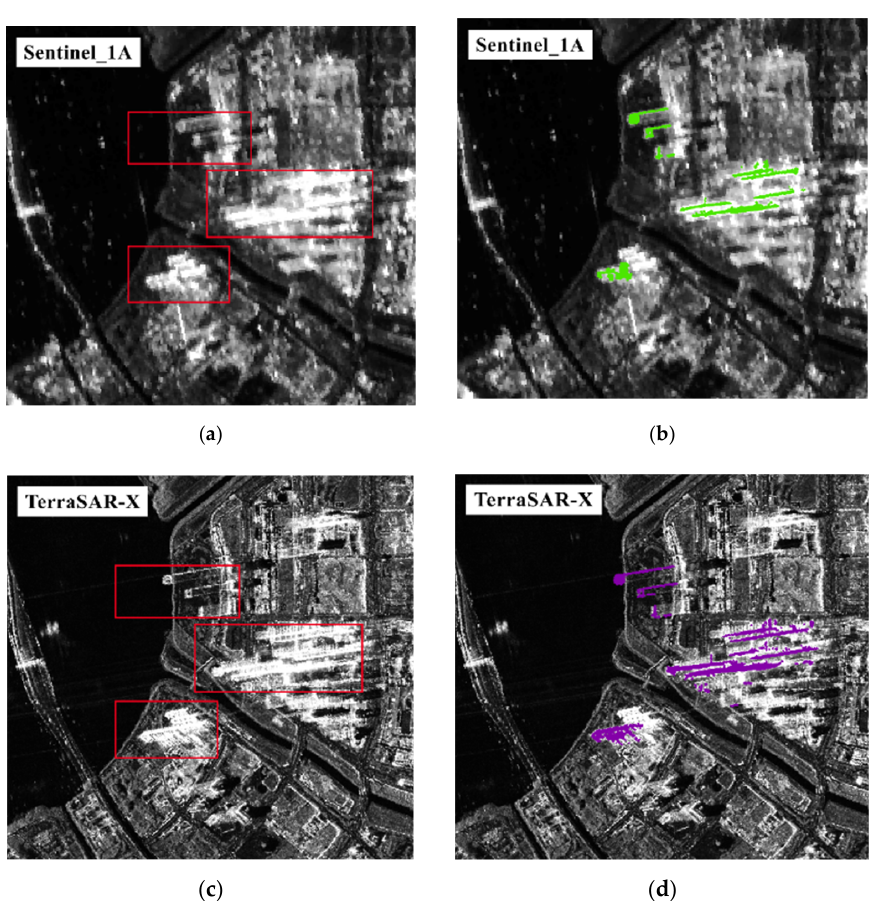
Figure 6. ( a ) Sentinel-1A image of the Qianhai Bay; ( b ) layover areas in the Sentinel-1A image; ( c ) TerraSAR-X image of the Qianhai Bay; ( d ) layover areas in the TerraSAR-X image. PS points corresponding to buildings are geometrically often seriously distorted, and there is a certain deviation when superimposed on an urban laser point cloud model, as shown in Figure 7a. The red and green dots represent the PS points of the Sentinel-1A and TerraSAR-X data, which display a distinct geometric deviation to buildings. The lower the resolution of the SAR images is, the more serious the deviation. To obtain an improved match between the SAR PS points and the urban laser point cloud model, the SAR points need to be refined. The DSM covering Shenzhen with a grid of2 m × 2 m derived by airborne LiDAR recordings was taken as control information to realize the high-precision geometric cor- rection. Figure 7b shows the InSAR match before and after geometric correction based on TerraSAR-X images, while Figure 7c,d illustrates the InSAR match before and after geo- metric correction based on Sentinel-1A images. The deviation of originally 4–5 pixels (more pixels for building) is reduced to about 2–3 pixels in the above operation, while the deviation of originally 3–4 pixels is reduced to about 1–2 pixels. The detailed variations of PS points during the geometric correction are shown in Table 4. Sentinel-1A-derived PS points of buildings increase by 1210, while TerraSAR-X-derived PS points of buildings decrease by 13191. The inconsistency in the change of control points can be related to the fact that the PS points of Sentinel-1A data obtained by SBAS-InSAR technology mainly include buildings, while the high-resolution TerraSAR-X data obtained by PS-SBAS-In-